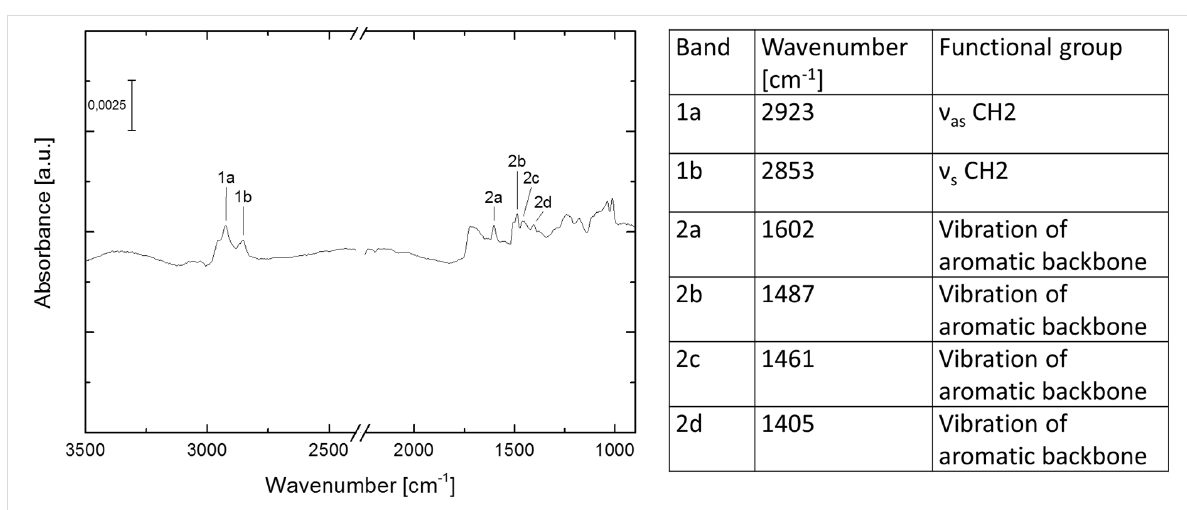
Figure 2: IRRA-Spectrum of the CMP thin film on a gold-coated silicon wafer and the corresponding band assignments.